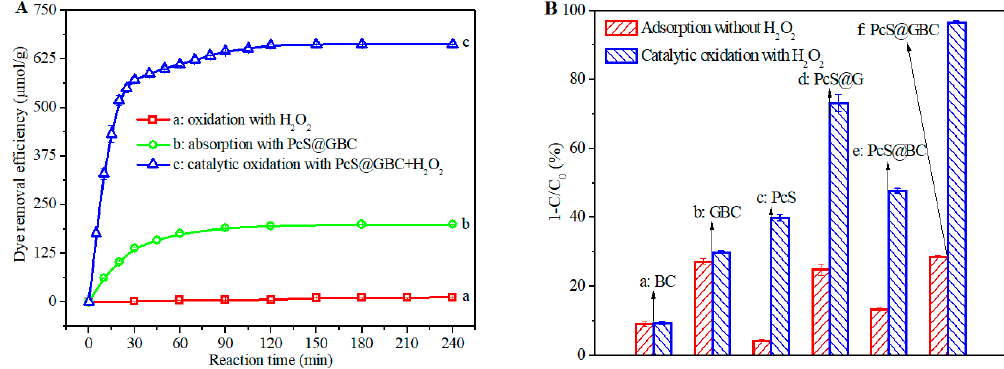
Figure 7. ( A ): Dye removal efficiency of a: H 2 O 2 (10 mM), b: PcS@GBC (0.75 mg), and c: PcS@GBC (0.75 mg) and H 2 O 2 (10 mM). ( B ): Comparison chart of dye concentration change by adsorption and